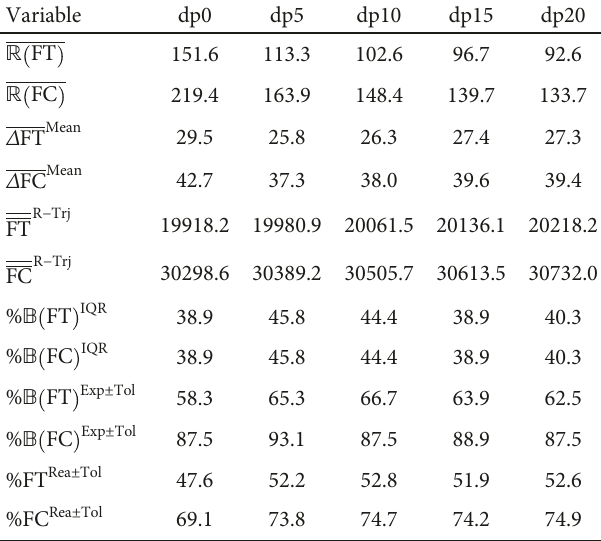
Table 2: Aggregated KPIs. Tol = 30 sec (FT) and 70kg